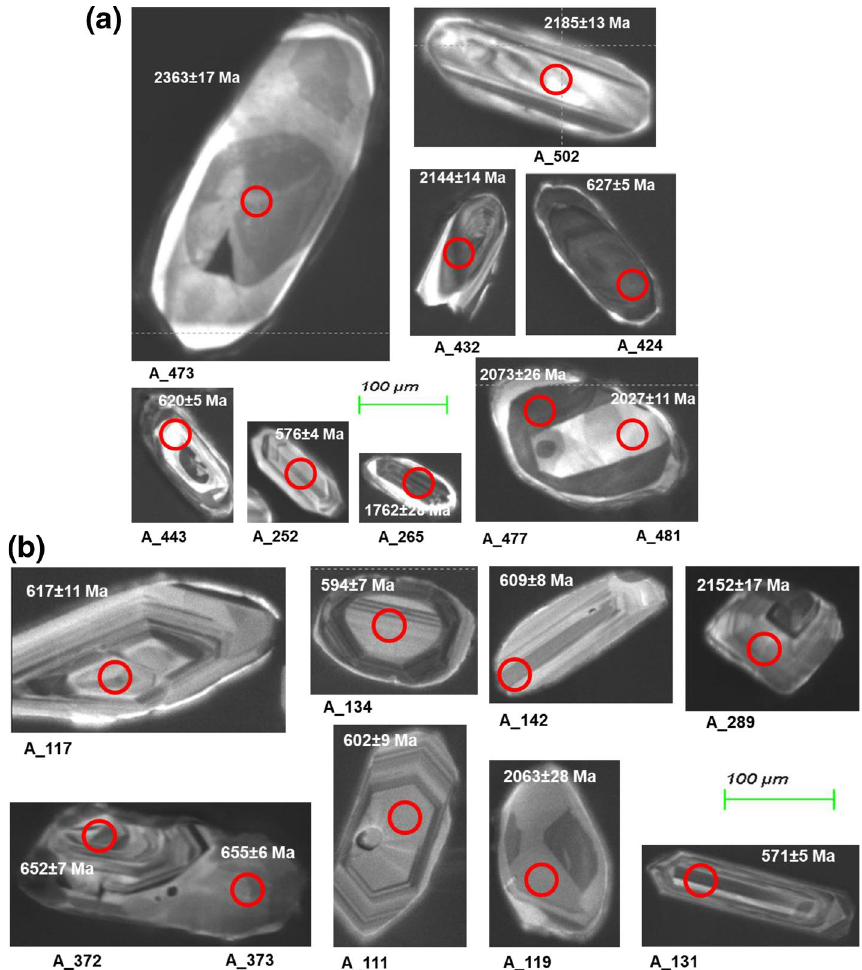
Figure 4. ( a ) CL images of selected zircon grains in the studied Cretaceous kaolins. Red circles indicate the spot location. ( b ) CL images of selected zircon grains in the studied Paleogene/Neogene kaolins. Red circles indicate the spot